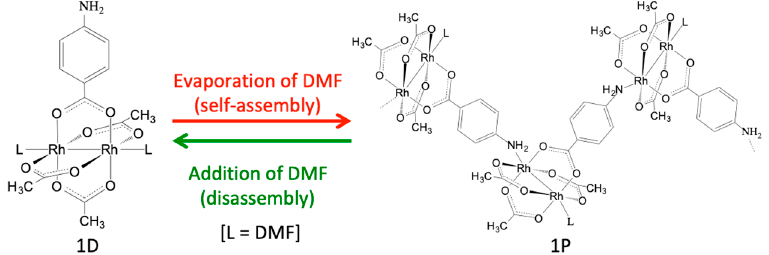
Figure 1. Self-assembly and disassembly transformations between [Rh 2 (O 2 CCH 3 ) 3 (PABC)(DMF) 2 ] ( 1D ) and [Rh 2 (O 2 CCH 3 ) 3 (PABC)(DMF)] n ( 1P ) .